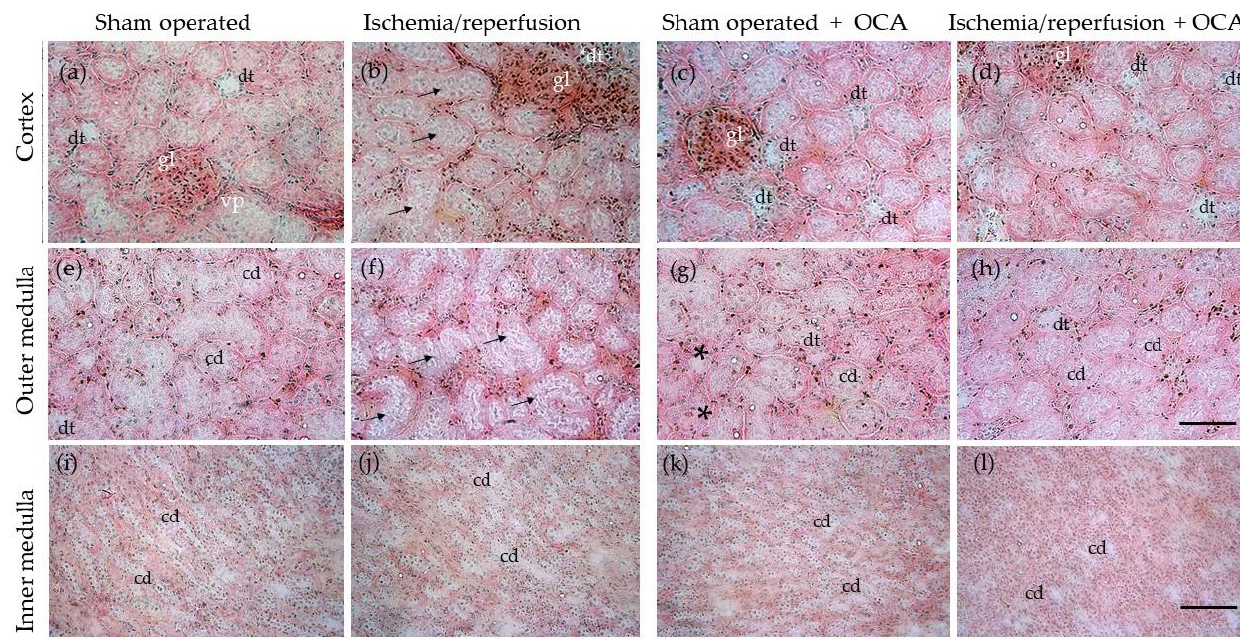
Figure 7. Histological patterns of kidneys (cortex and outer and inner medulla) collected from rats orally administered 10 mg/kg/day OCA in methylcellulose 1% for 5 days ( n = 12) or vehicle alone ( n = 12), and then submitted to partial liver ischemia (60 min) followed by reperfusion (120 min). Sham-operated animals were subjected to the same procedure without clamping the vessels. Cryostatic tissue sections are stained by conventional H&E procedure. ( a – d ) In the cortex the intensely stained glomeruli, or renal corpuscles, (gl) exhibit their typical rounded shape. In ( a ) the vascular pole (vp) is also easily appreciable. Distal tubules (dt) can be recognized for their much less eosinophilia than the proximal ones. ( e – h ) Cross-sections of medulla are characterized by collecting ducts (cd), larger than distal tubules (dt) and segments of the loop of Henle (asteriscs). ( i – l ) In the longitudinal sections of medulla, arrays of nuclei facing larger, empty spaces identify collecting duts (cd). Ischemia-reperfusion affects in particular the tubules in the cortex and outer medulla of rats without OCA administration, for which the lumen appears to be enlarged and filled with amorphous material (arrows). Bars: ( a – h ) 80 μ m; ( i – l ) 50 μ m.